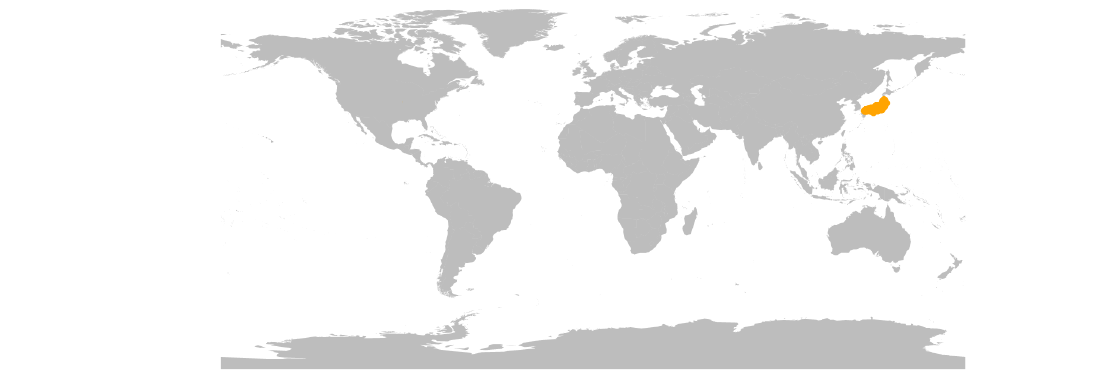
Fig. 35. Distribution of Malus tschonoskii (Maxim.)